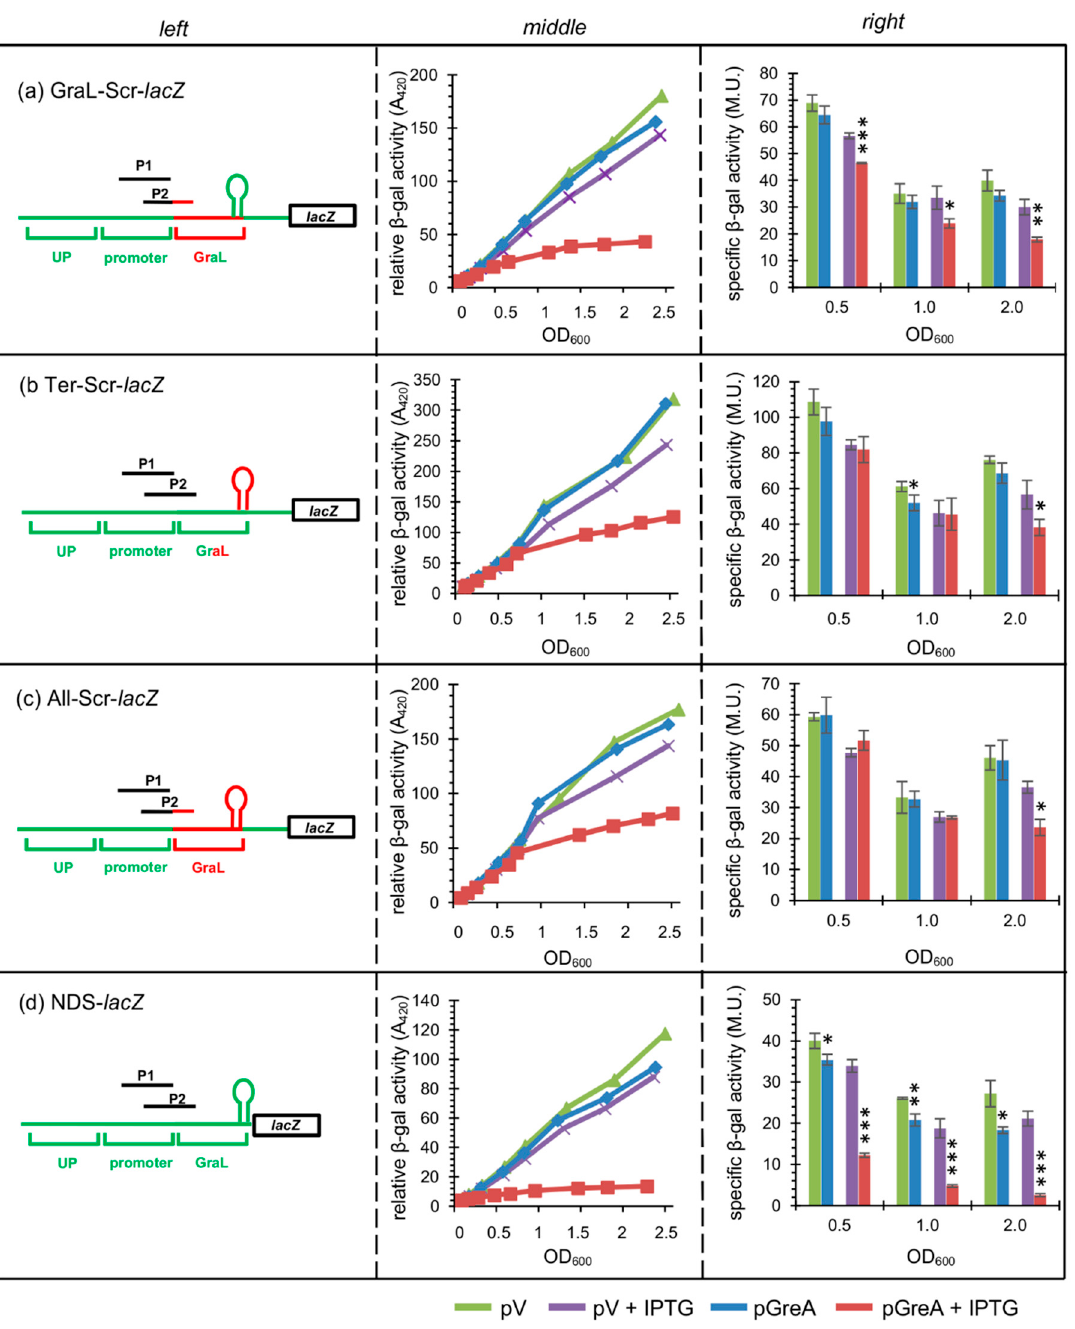
Figure 6. The GraL sequence (both upstream of and forming the terminator hairpin) determines autoregulation exerted by GreA. Assessment of β -galactosidase activity in strains overproducing GreA from a multicopy plasmid (pGreA) for: ( a ) GraL–Scr– lacZ (region from + 1 to + 18 scrambled); ( b ) Ter–Scr– lacZ (terminator hairpin arms switched with each other); ( c ) All–Scr– lacZ ((a) and (b) combined); ( d ) NDS– lacZ (“no downstream region”) fusions. Wt ∆ lacZ (CF15617) strains carrying appropriate single copy fusions were grown in LB at 32 ◦ C with aeration; if present, IPTG was added at OD 600 ~ 0.1 to 1 mM; pV—vector control. Left panels—schematic representation of the lacZ fusions employed; hairpin symbolizes the GraL terminator; not drawn to scale. Middle panels—di ff erential plots of β -galactosidase activities vs. OD 600 , following transcriptional activity throughout growth. The slope of each curve corresponds to the specific activity of β -galactosidase. Right panels—specific β -galactosidase activities assessed for each strain at OD 600 ~ 0.5, 1.0, and 1.5 (experiment was done in triplicate). Error bars represent S.D. For clarity, p -values calculated for pV vs. pGreA, and pV + IPTG vs . pGreA + IPTG are only shown. * p < 0.05, ** p < 0.005, *** p < 0.0005.